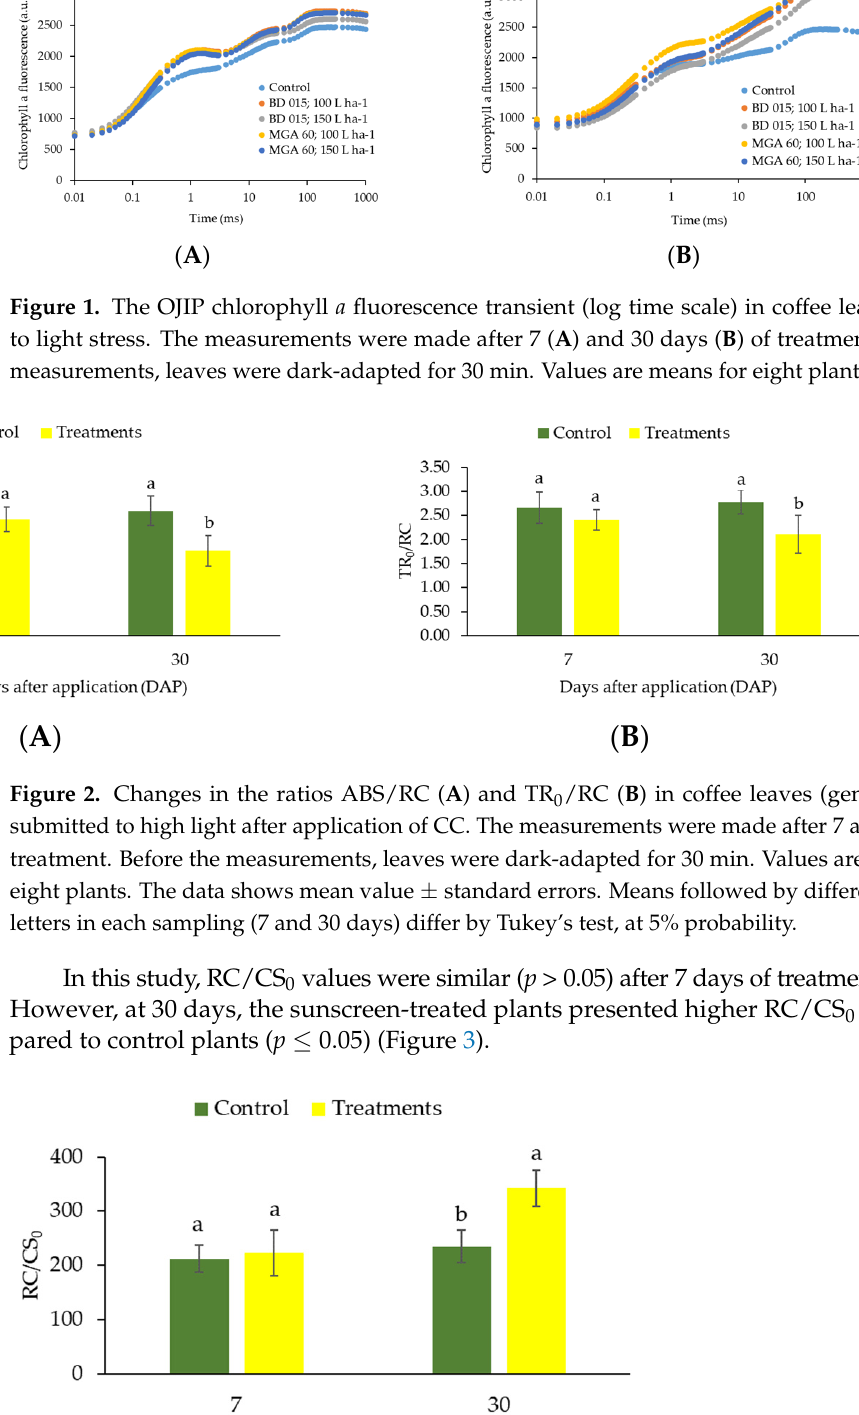
Figure 1. The OJIP chlorophyll a fl uorescence transient (log time scale) in co ff ee leaves exposed to light stress. The measurements were made after 7 ( A ) and 30 days ( B ) of treatment. Before the meas- urements, leaves were dark-adapted for 30 min. Values are means for eight plants.